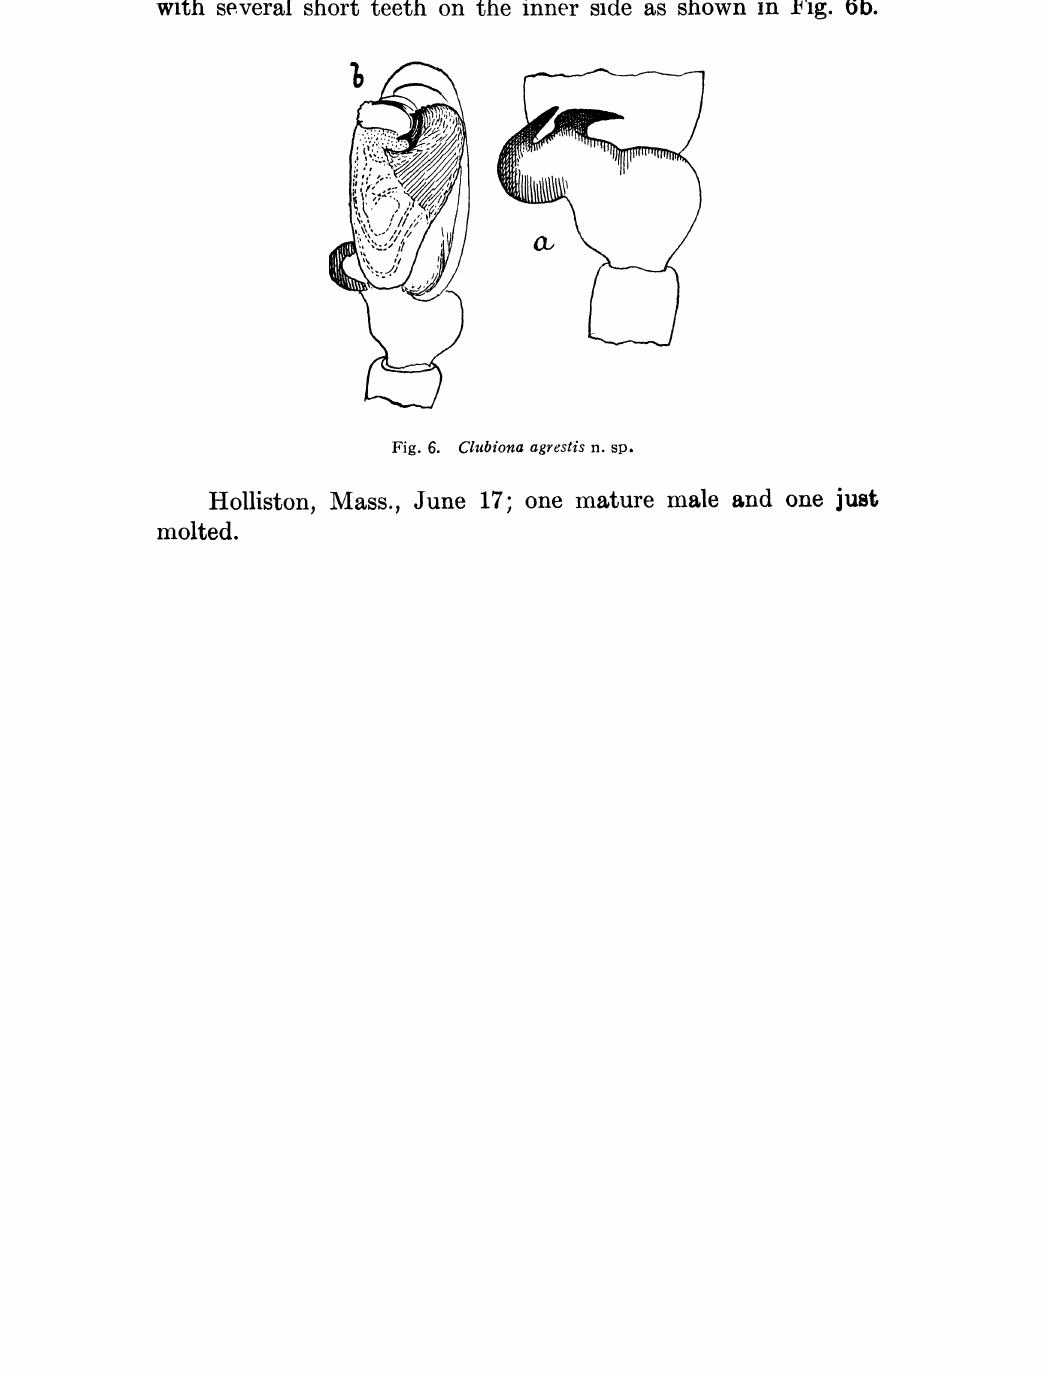
Fig. 6. Clubiona agrestis